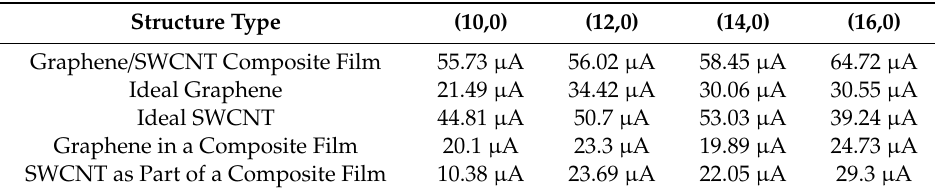
Table 2. Maximum current for graphene / SWCNT composite films and for individual graphene and SWCNT at a voltage of